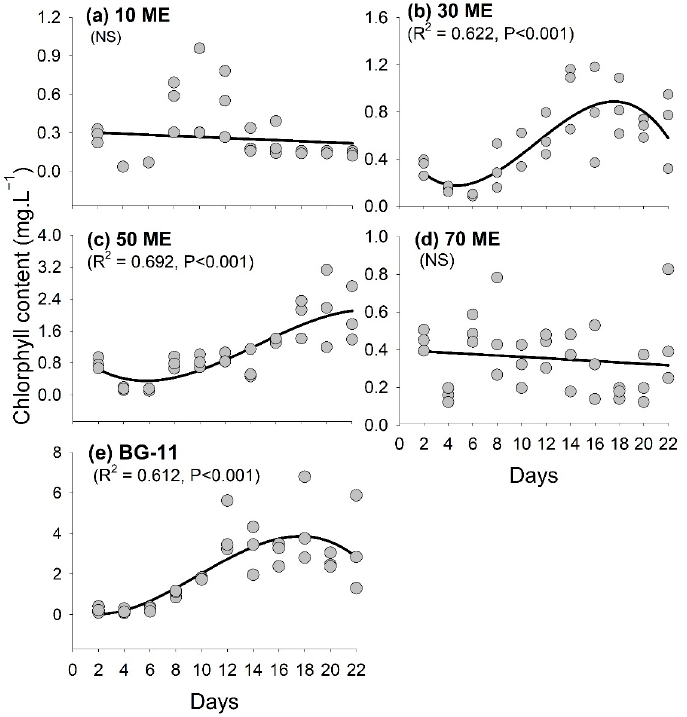
Figure 6. Variation of chlorophyll content of Chlorella sp. cultivated in ( a ) 10 ME, ( b ) 30 ME, ( c ) 50 ME, and ( d ) 70 ME of malting effluent and ( e ) BG-11 standard mineral media during 22 days of cultivation time. The regression lines are derived from polynomial third-order regression.